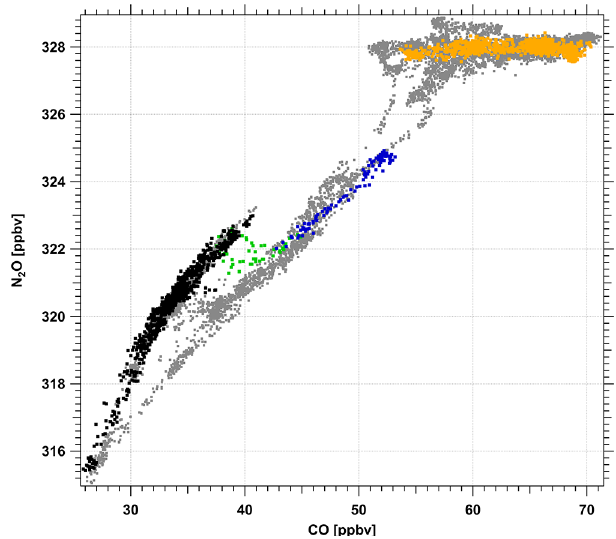
Figure 5. Scatterplot of N 2 O versus CO for FF09 on 12 July 2014. The light gray points show the correlation of N 2 O and CO for the whole flight. For the upper southwestern flight leg from 18:48 to 19:06UTC in Fig. 2 (also compare Fig. 6), the data points are black, blue and green. Black colors indicate potential temperatures (cid:50)> 328.1K, blue for (cid:50)< 326.3K. The region between these two levels is marked in green. The lower leg lies entirely in the tropo- sphere as indicated by the orange data points of N 2 O =